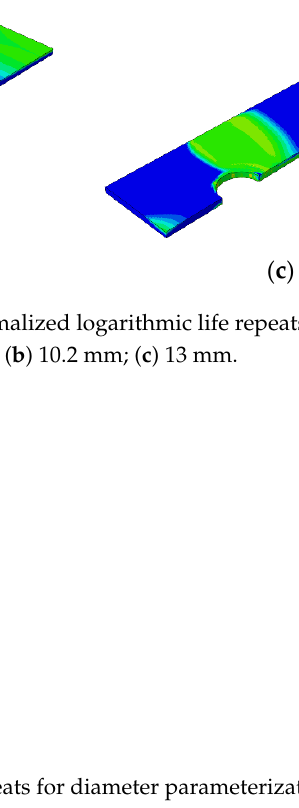
Figure 15. Fatigue distribution of the normalized logarithmic life repeats in the lower plate for the model with a bolt diameter of: ( a ) 8.2 mm; ( b ) 10.2 mm; ( c ) 13 mm.